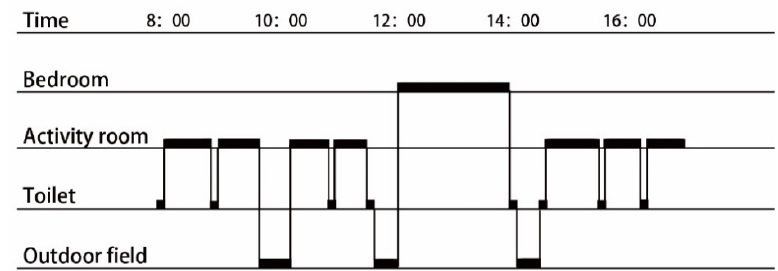
Figure 2. Daily life routines of the kindergartens.